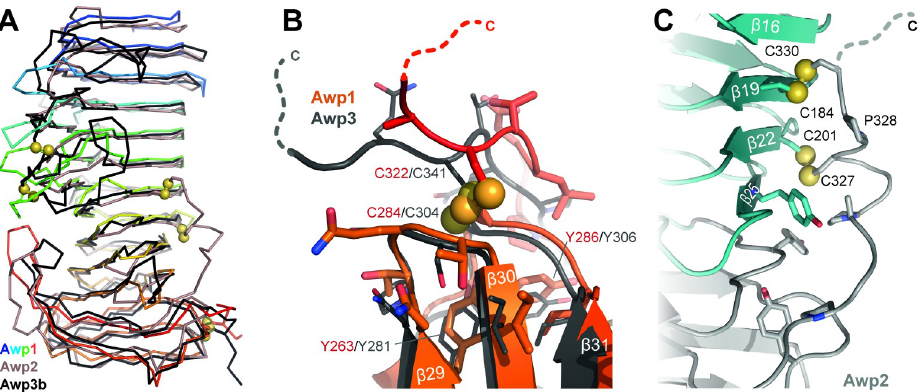
Fig 5. Similarity and disulfide bridges in Awp1, Awp2 and Awp3b A-regions. (A) Superpositions of the Awp1 and Awp3b A-region crystal structures with the trRosetta model of Awp2A. Despite the limited sequence identity of 24% to the Awp3b A-region, the Awp3b-A structure closely resembles the Awp1 A-region with an r.m.s.d. of 1.4 Å for 223 C α -atoms. (B) Disulfide bridges between the C-terminal cysteine residue and the α -crystallin domains of Awp1 and Awp3b A-regions. (C) Predicted disulfide bridges between the C-terminus and β -helix turns of the trRosetta model of the Awp2